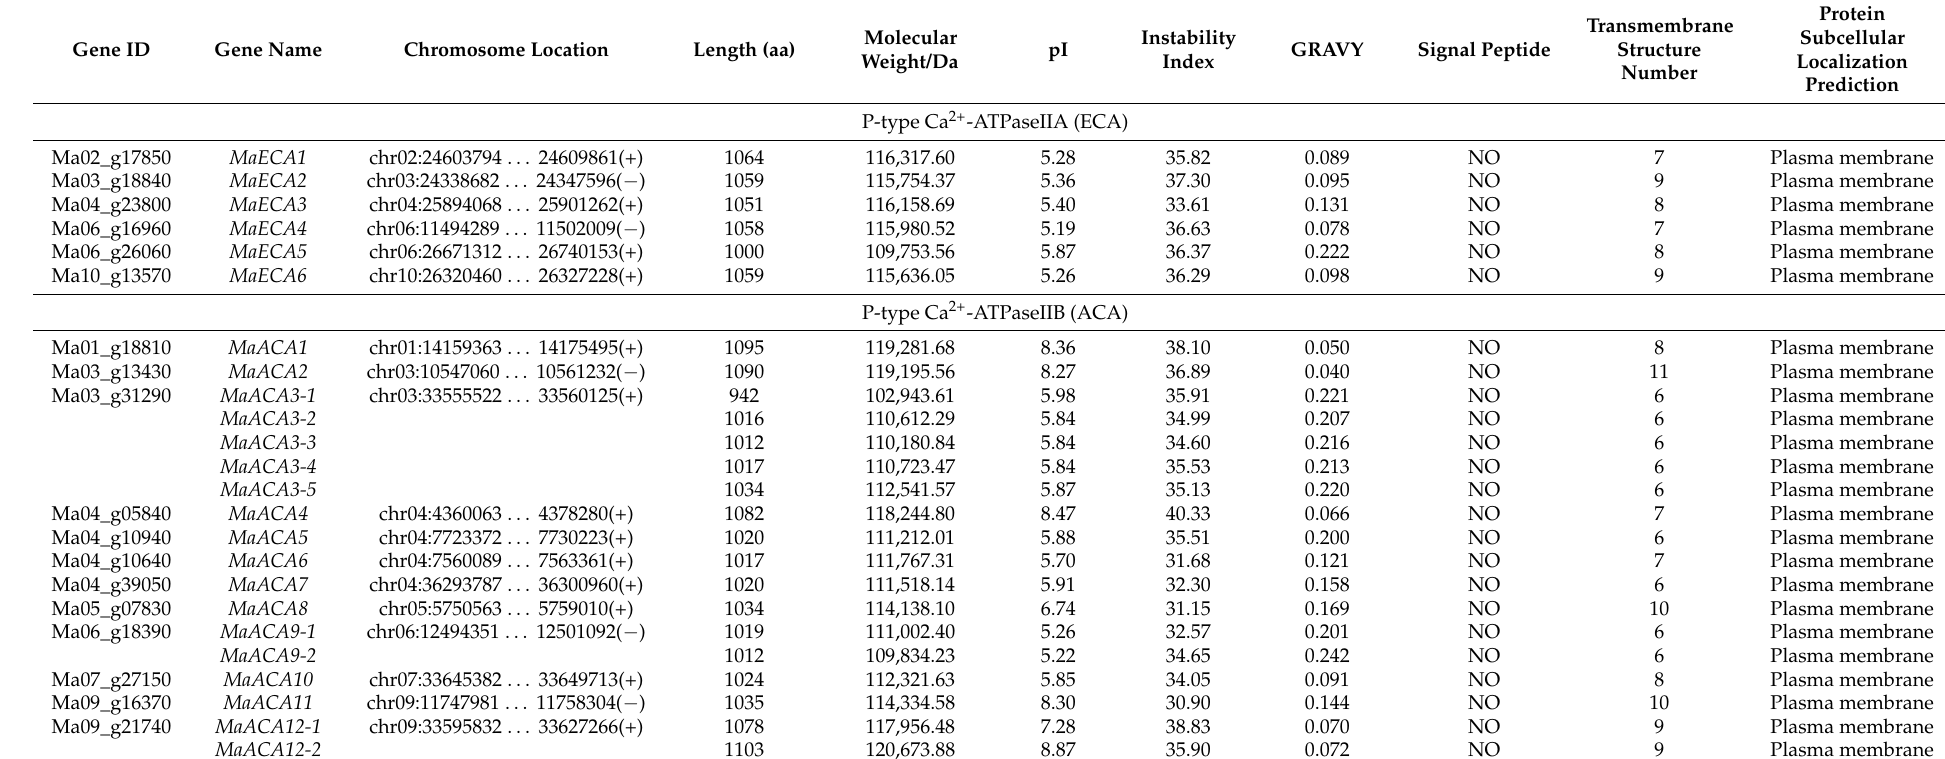
Table 1. Physicochemical properties of the banana Ca 2+ -ATPase family